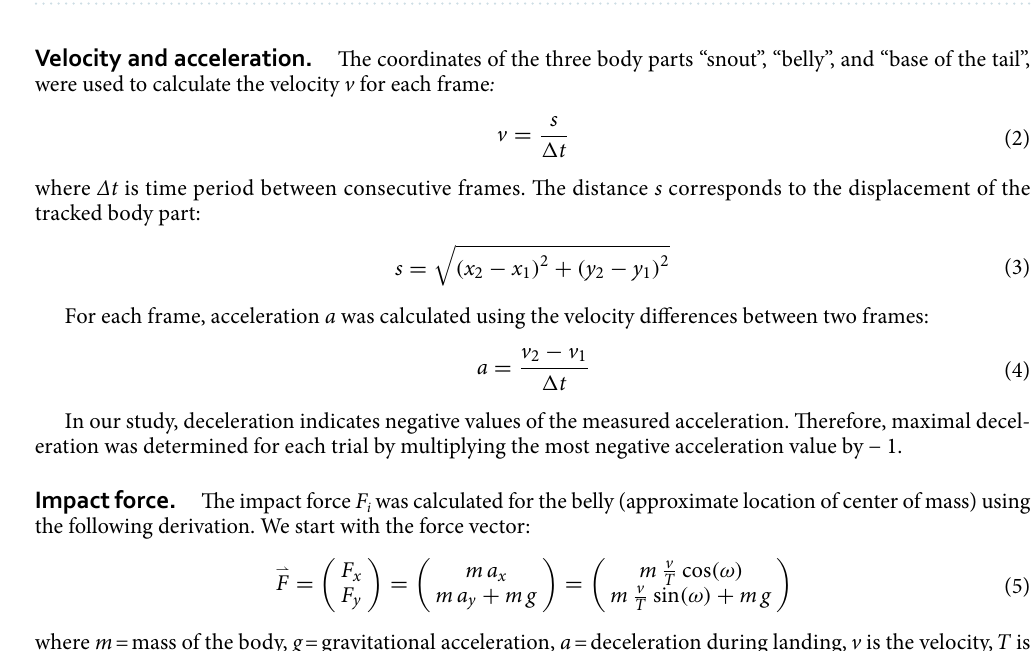
Figure 3. Factors determining the impact force. The velocity v of the gecko reaching the landing platform can be separated into velocity v ┴ perpendicular to the surface and velocity v ║ parallel to the surface. The perpendicular acceleration g ┴ and the parallel acceleration g ║ are part of gravitational acceleration g acting on the gecko’s body. The angle α lies between (cid:31) v and the platform. The angle φ corresponds with the platform incline towards the horizontal (dashed